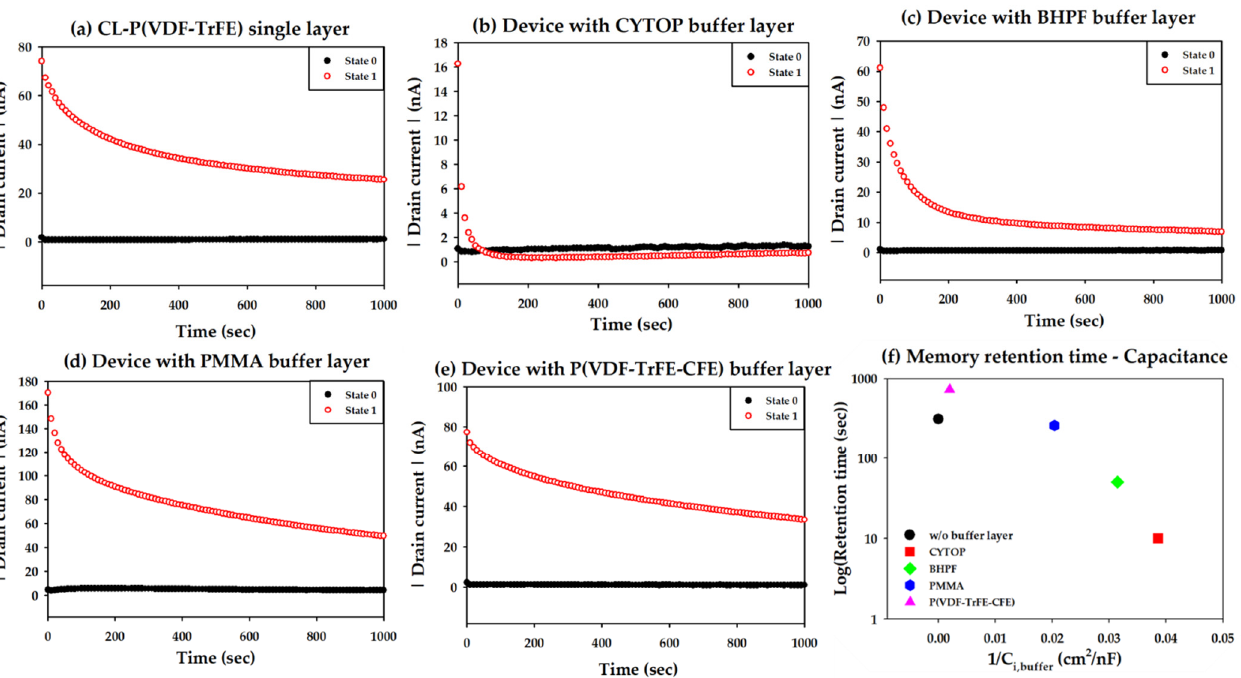
Figure 4. Memory retention characteristics of OFETs ( a ) without the buffer layer, and with a buffer layer of ( b ) CYTOP, ( c ) BHPF, ( d ) PMMA, or ( e ) P(VDF-TrFE-CFE). ( f ) Retention times corresponding to the capacitance of the buffer layers.